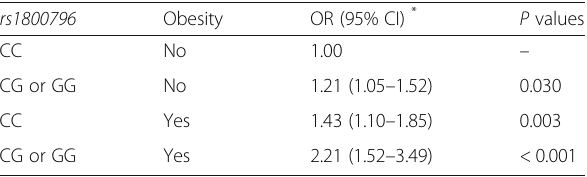
Table 5 Stratified analysis for interaction between rs1800796 and obesity using logistic